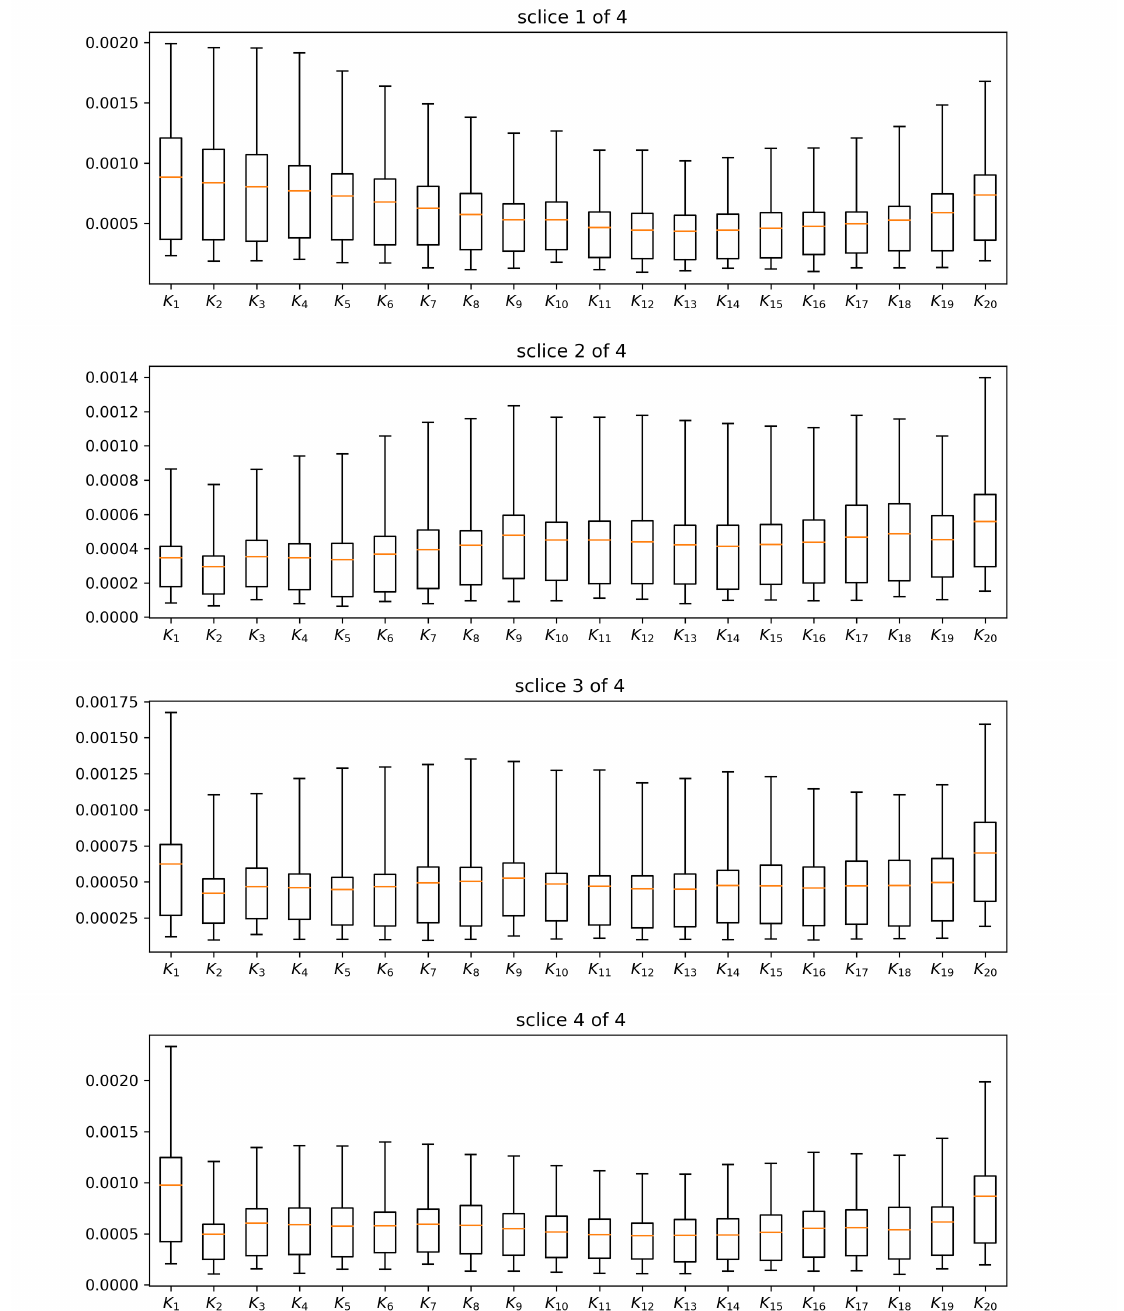
Figure 5. Boxplots of absolute calibration errors of implied volatilities for the statistical test as specified in Section 4.1.2 for the four synthetic market data slices (maturities). The errors for K j in the i -th row correspond to the calibration error of the synthetic market implied volatility for strike K i , j . Depicted are the mean (horizontal line), as well as the 0.95,0.70,0.3,0.15 quantiles for the absolute calibration error per